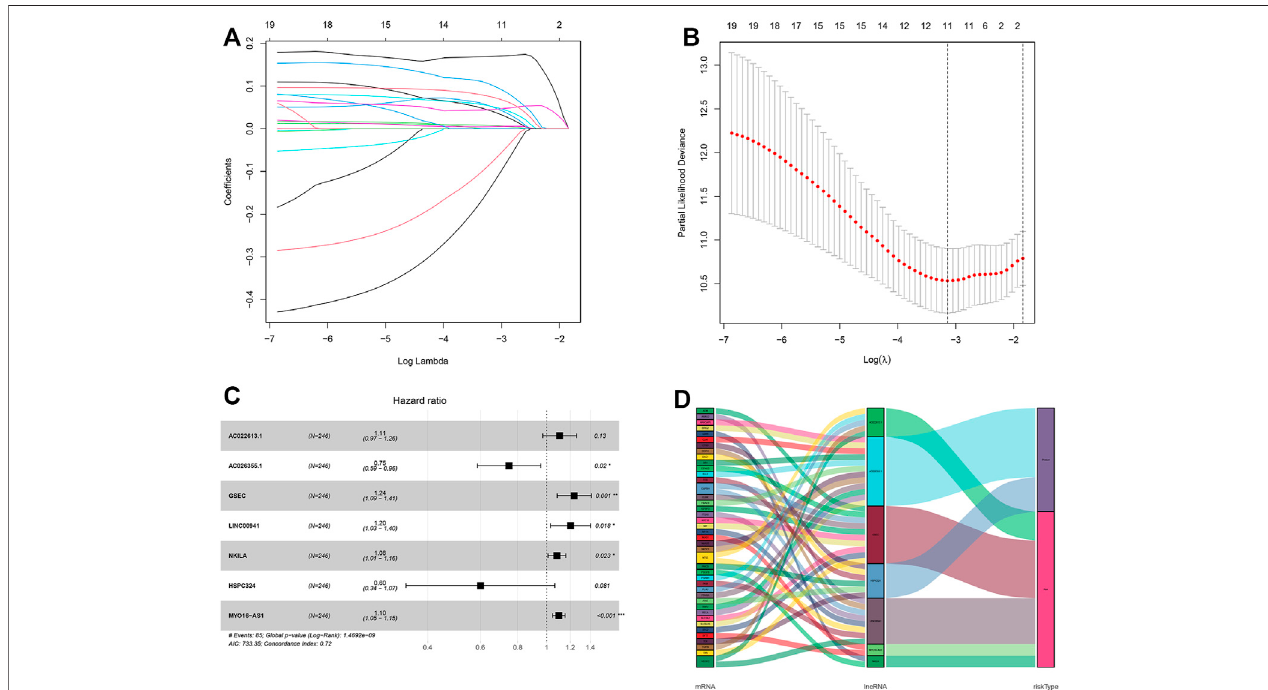
FIGURE 3 | Identi fi cation and construction of a hypoxia-related lncRNAsignature in the training cohort. (A,B) Robust lncRNAswere screened by LASSO analysis. (C) Forest plot of the multivariate Cox regression model. (D) Sankey diagram shows the lncRNA – mRNA interaction about hypoxia. * represents p < 0.05, ** represents p < 0.01, and *** represents p < 0.001.